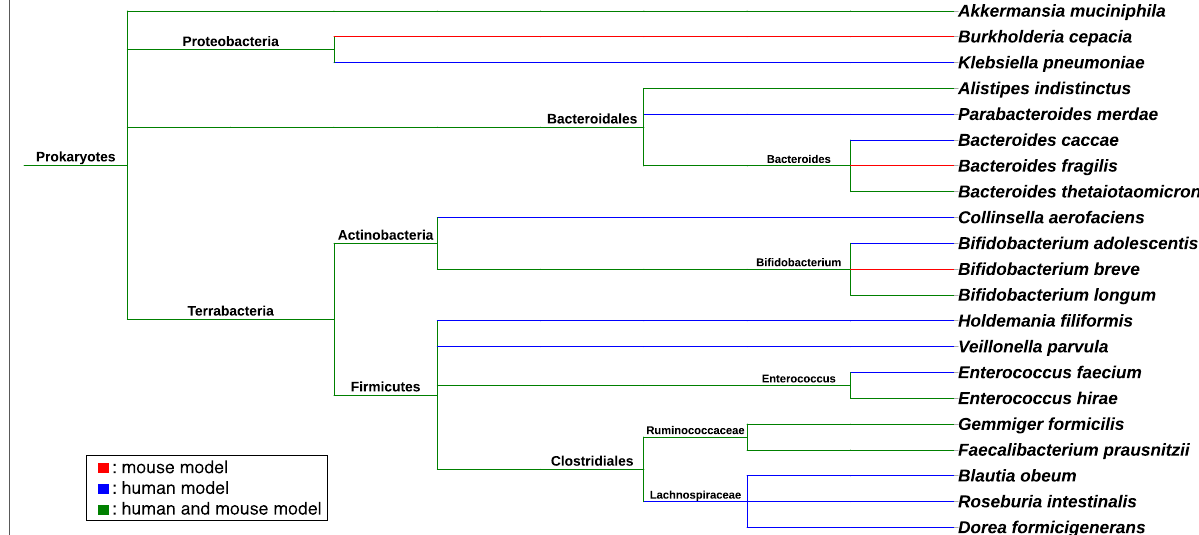
Fig. 1 Phylogenetic tree of gut commensal bacteria associated with response to immune checkpoint inhibitors in both preclinical and clinical studies. Taxonomic classification is based on (from left to right) domain, phylum, order, family, genus, and species except for Terrabacteria (unranked). Figure created using the phylogenetic tree software by: